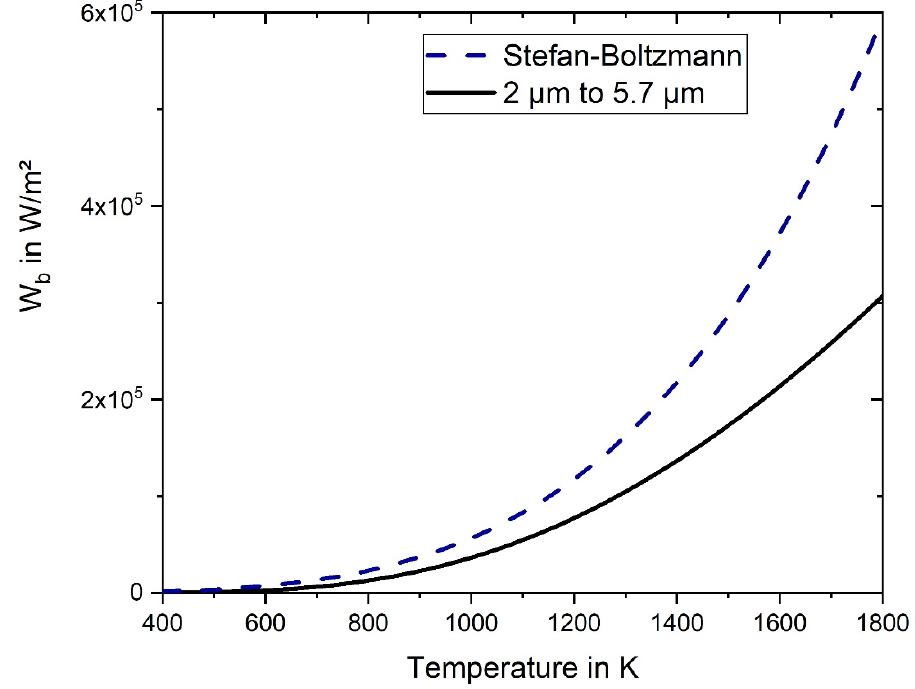
Figure 2. Theoretical calculations of radiant exitance W b using the Stefan-Boltzmann approach and an integration through a limited spectrum of wavelengths.